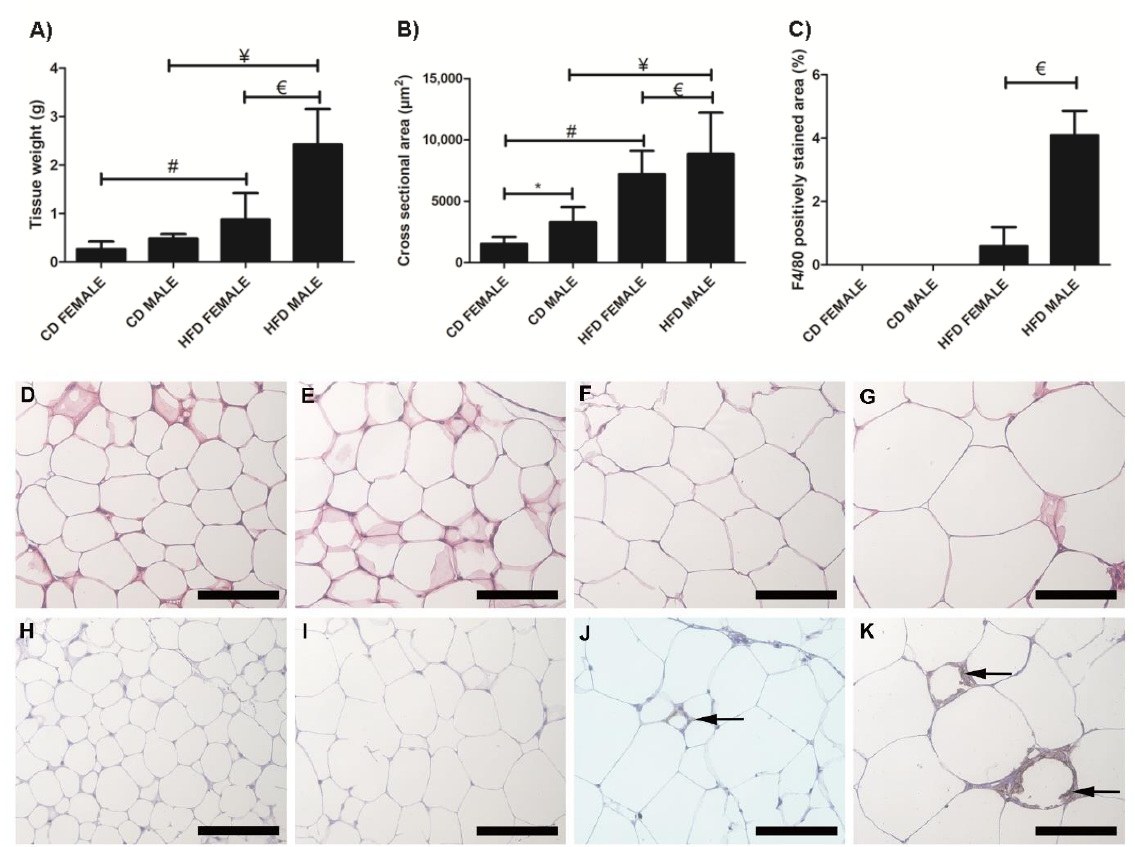
Figure 3. Histology and immunohistochemistry of pWAT sections. Weight of pWAT sections, ( A ); cross sectional area of adipocytes, ( B ); and F4/80 macrophage-stained area, ( C ). Adipocyte hypertrophy was evident in HFD males, ( G ) and females, ( F ) compared to CD males, ( E ) and female, ( D ), respectively. F4/80+ immunostained sections from the CD females, ( H ); CD males, ( I ); HFD females, ( J ); and HFD males, ( K ). Macrophage infiltration (black arrow) was evident only in the HFD females, ( J ); and males, ( K ); no macrophages were observed in the CD females, ( H ); and males, ( I ). A significantly greater macrophage infiltration was observed in the HFD males compared to HFD females, ( C ). * Significant difference between the CD females and CD males, p < 0.05. # Significant difference between CD female and HFD female, p < 0.05. ¥ Significant difference between CD male and HFD male p < 0.05. € Significant difference between HFD female and HFD male, p < 0.05. Mean ± SD. Scale bar: 100 µm.